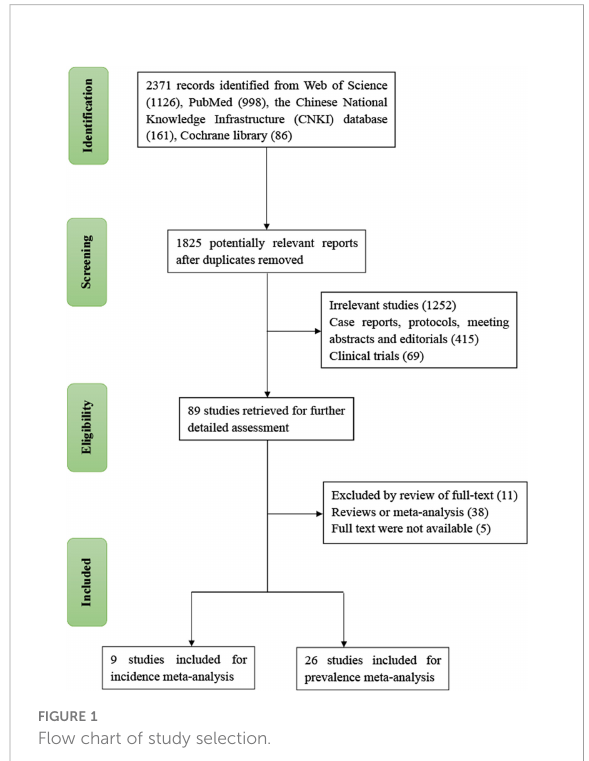
FIGURE 1 Flow chart of study selection.